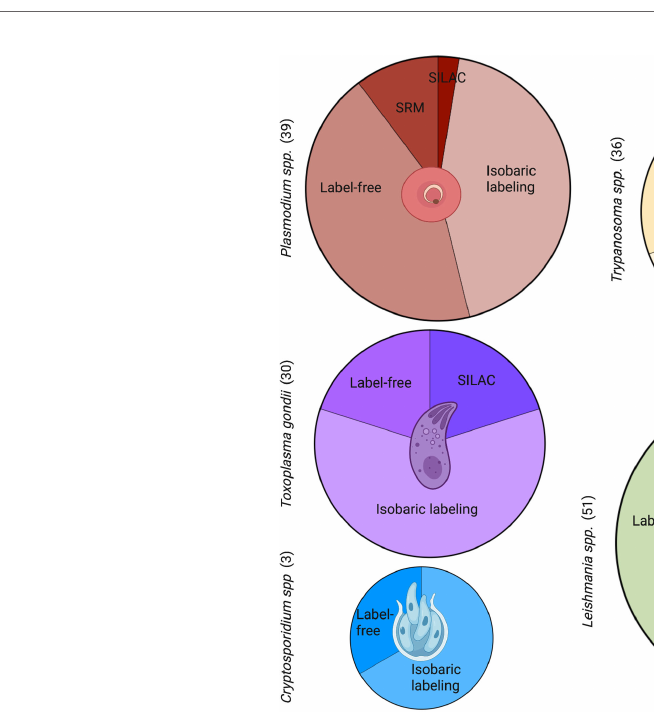
FIGURE 6 | Commonly used quantitative methods to study proteomics in Apicomplexans and Kinetoplastids. A PubMed search was carried out for each genus with key terms for the proteomic methods. The number of publications by term and by parasite are shown in brackets. Leishmania had the most quantitative proteomic publications, followed closely by Plasmodium , Trypanosoma , and Toxoplasma . Both Leishmania and Plasmodium showed a larger diversity of methods with the inclusion of SWATH-MS and SRM, respectively. Cryptosporidium had the least amount of publications in quantitative proteomics and least diversity of methods. SRM, selected reaction monitoring; SILAC, stable isotope labelling by amino acids in cell culture; SWATH-MS, sequential window acquisition of all theoretical mass spectra. Figure created with